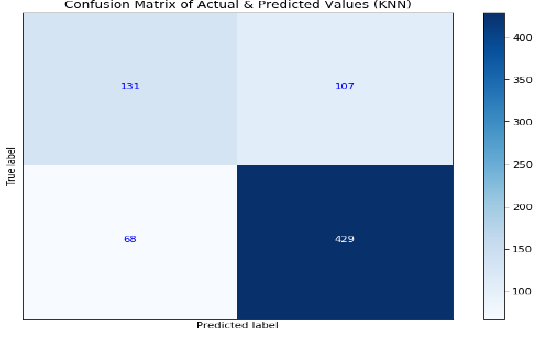
Figure 4. The k-nearest neighbors ( k NN) CM Result